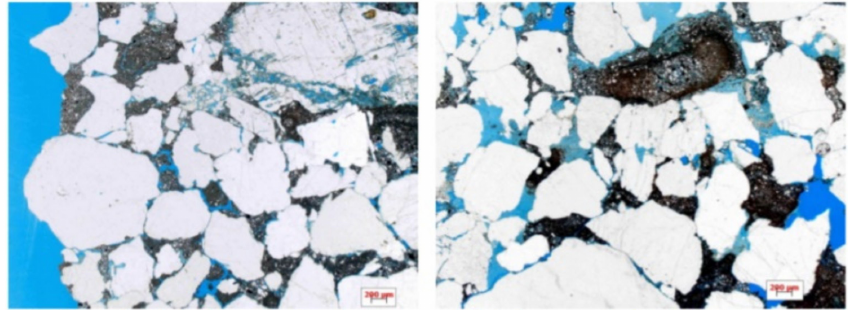
Figure 18. Photomicrograph showing thin-section analysis results for post-formation-damage testing of rock material using drilling fluid with non-optimised bridging particles. The dark or brown substances are solid particles from drilling fluid [73].